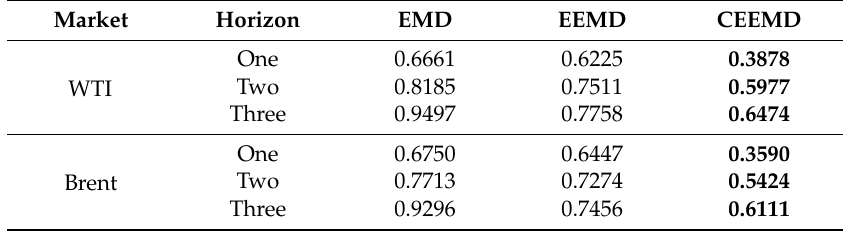
Table 9. The RMSE values of different decomposition methods on WTI and Brent crude oil prices.